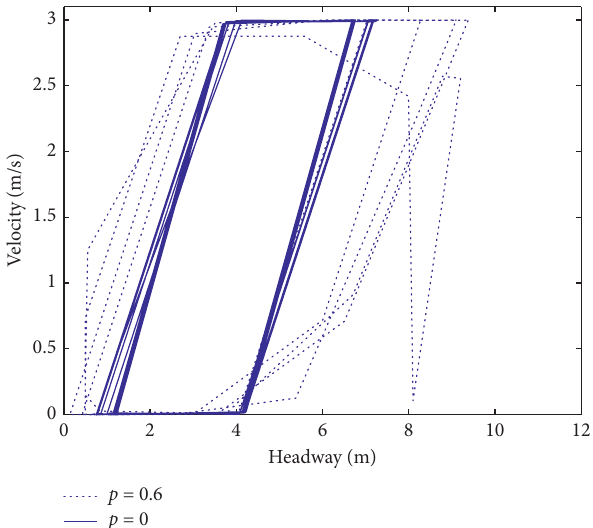
Figure 8: Hysteresis loops after t � 10000s with different sets of p